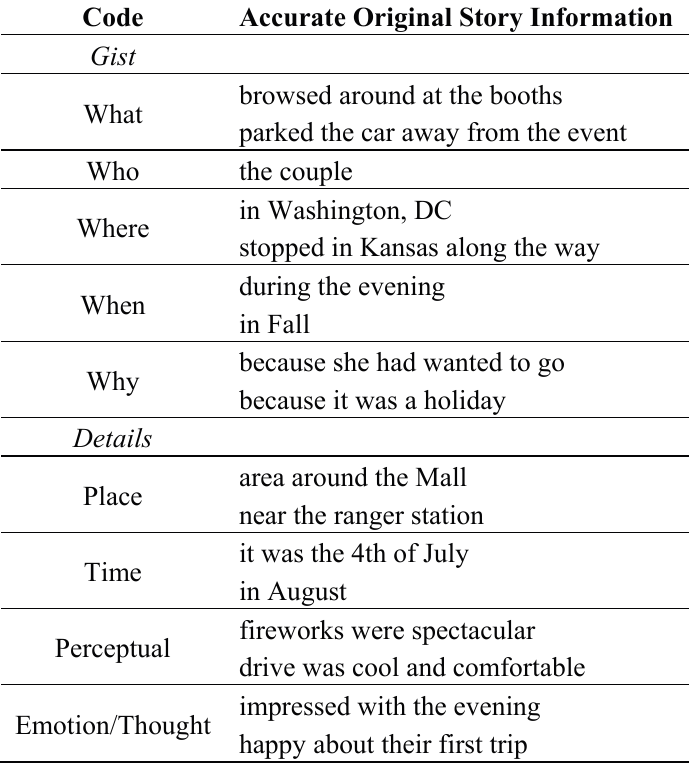
Table 1. Examples of coding schemes for accurate information recalled for gist and